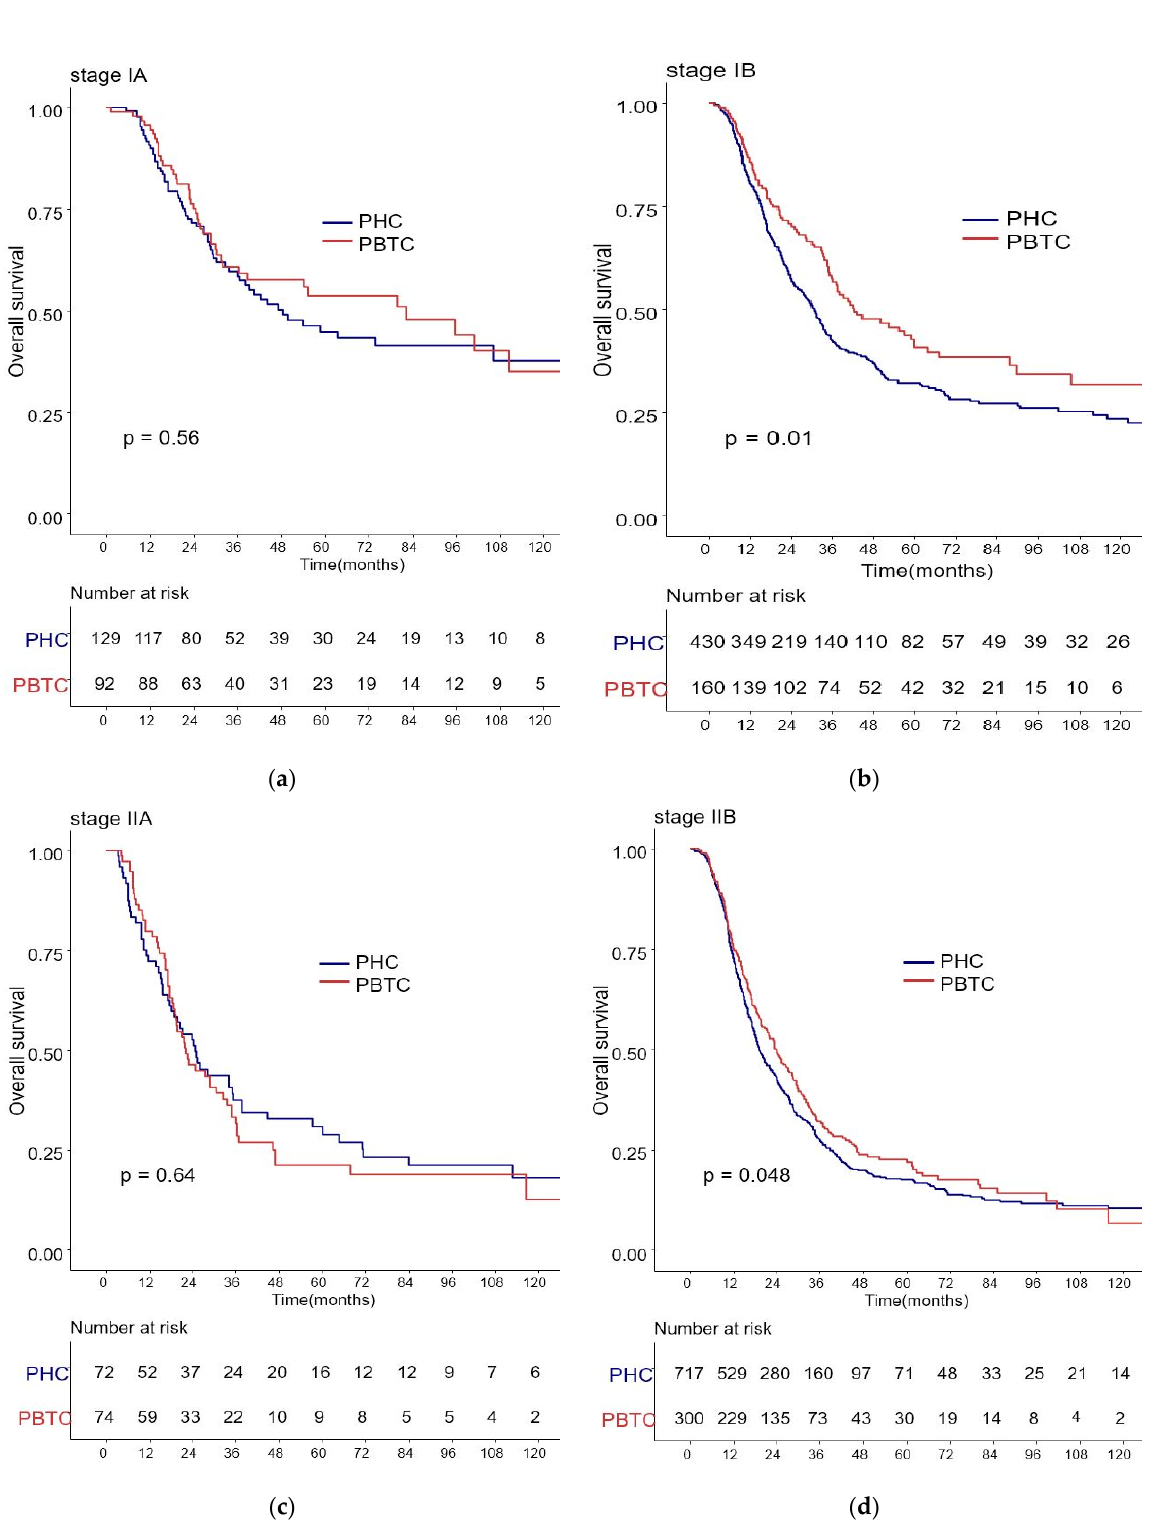
Figure 3. Kaplan–Meier survival curves of the cases in pancreatic head cancer (PHC) group and pancreatic body/tail cancer (PBTC) group, stratified according to the American Joint Committee on Cancer (AJCC 8th edition) Tumor-Node-Metastasis (TNM) staging system. ( b ) The survival rates were lower in PHC patients compared with PBTC patients in stage IB (30 months vs. 42 months, p = 0.011) and ( d ) stage IIB (19 months vs. 23 months, p = 0.048). ( a , c ) No significant difference between the two groups was observed for stages IA and IIA.